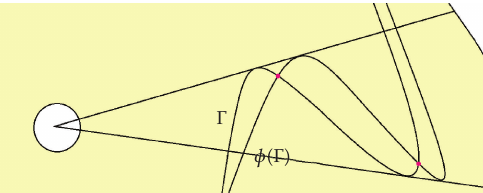
Figure 1: A sketch of the problem in Wilson’s argument. We depict a sector of an annular domain in which there is a portion of a non-star-shaped curve Γ where Θ (cid:7) 0. The points of Γ are moved radially to the points of φ (cid:3)Γ(cid:4) with preservation of the area. The points in Γ ∩ φ (cid:3)Γ(cid:4) are not fixed points for φ . A similar situation is described by Martins and Ure˜na in (cid:5) 6, Figures 1-2 (cid:6) .